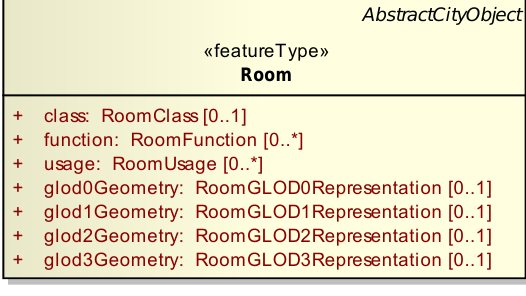
Figure 11: Room class